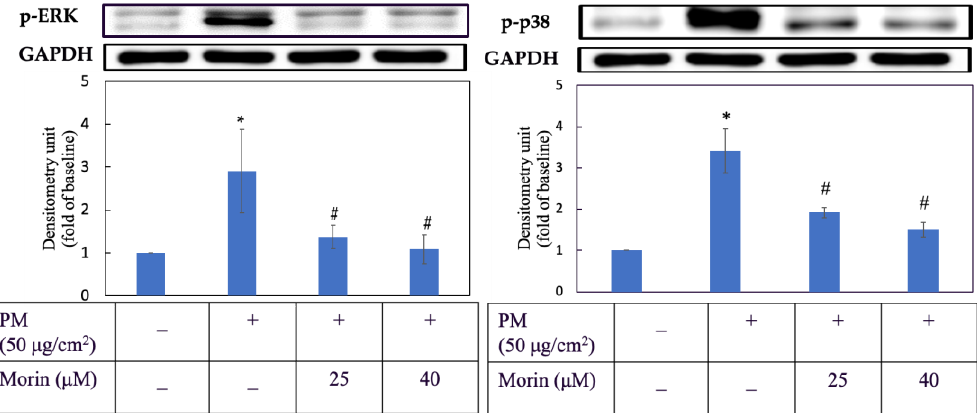
Figure 4. p-ERK and p-p38 expression. Cells were pre-incubated with morin for 3 h and then treated with PM for 2 h. +, − mean with or without exposing to PM or morin, respectively. Data were presented as mean ± SD and from triplicate experiments. *, # indicates a statistically significant difference with control group (without treating PM and morin) and PM group (only treating PM), respectively, p < 0.05.